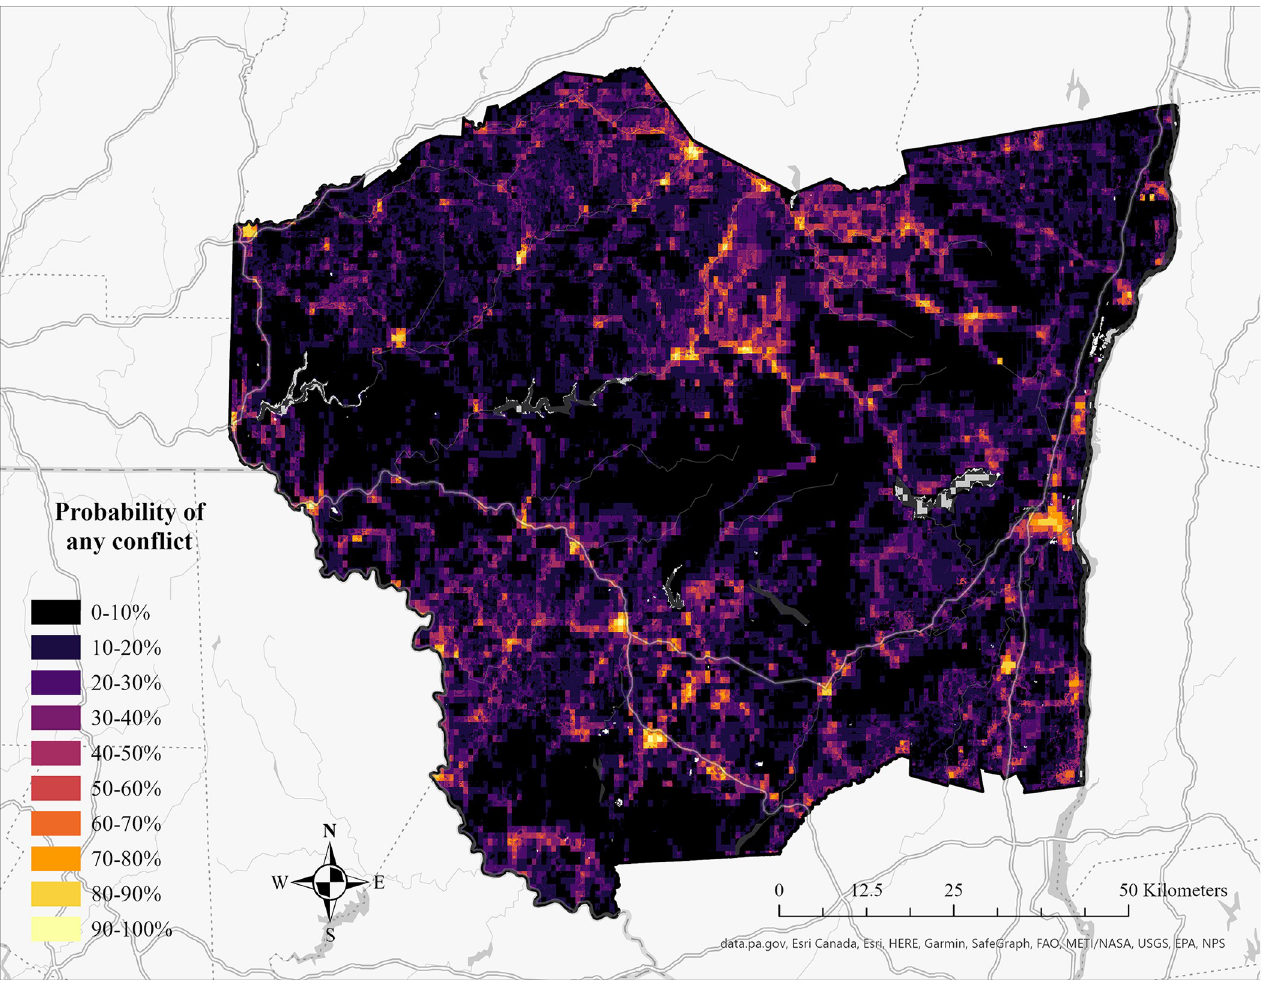
Fig 3. Map depicting risk human-black bear conflicts in the Catskills region of New York. Map is based on our optimal RSPF model. Brighter, warmer colors indicate a higher probability of conflict, while darker, cooler colors represent low-risk areas of conflict.